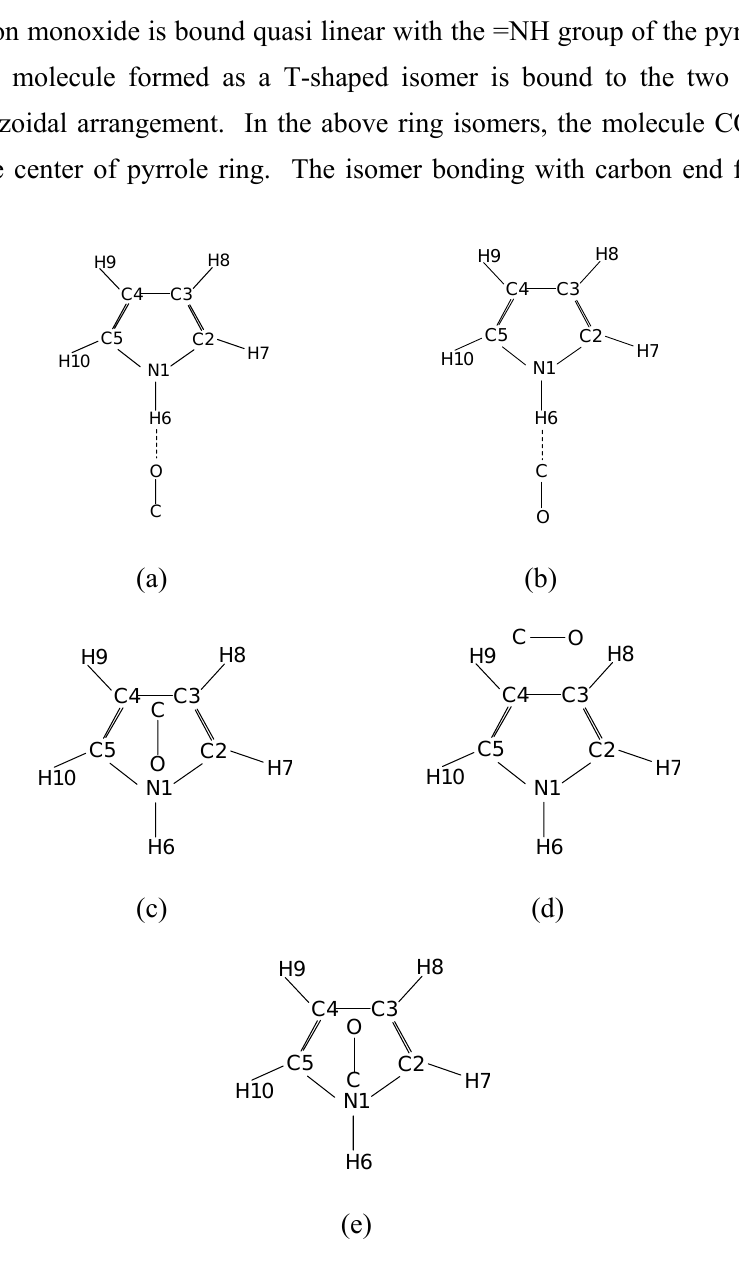
Figure 2 . Isomers of pyrrole...carbon monoxide complex (a) hydrogen bonded O end first, (b) hydrogen bonded C end first, (c) above ring OC, (d) T-shaped and (e) above ring